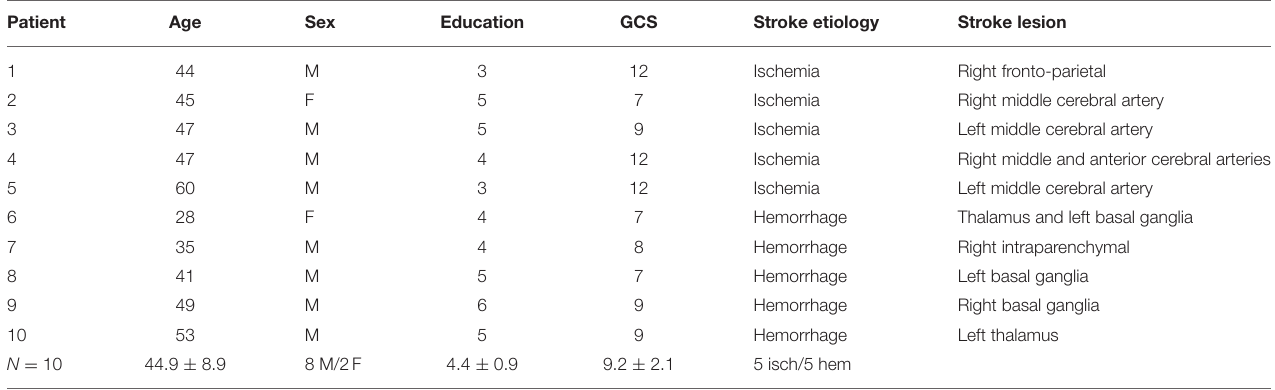
TABLE 1 | Clinical and sociodemographic characteristics of the patients.